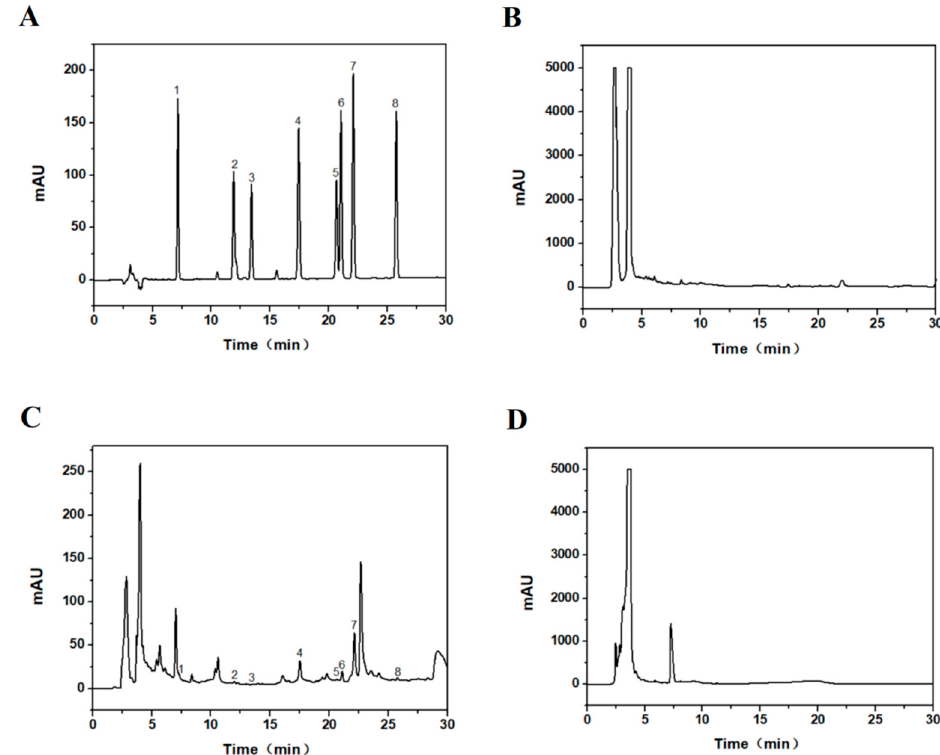
Figure 2. ( A ) HPLC detection chart of eight taxane standards (125 µ g/mL), ( B ) HPLC chart of the crude Taxus cuspidata extract before purification, ( C ) HPLC chart after purification with water as the recrystallization antisolvent, and ( D ) HPLC chart of the recrystallized water layer.